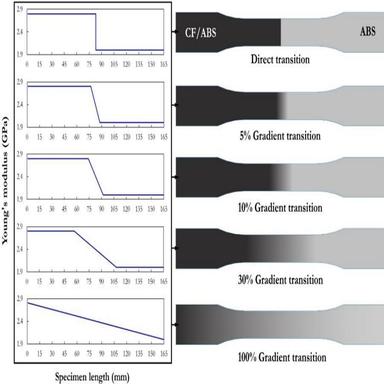
Designed interface patterns, (a) material transition functions, (b) tensile test specimens with various transitions from CF/ABS to neat ABS material.